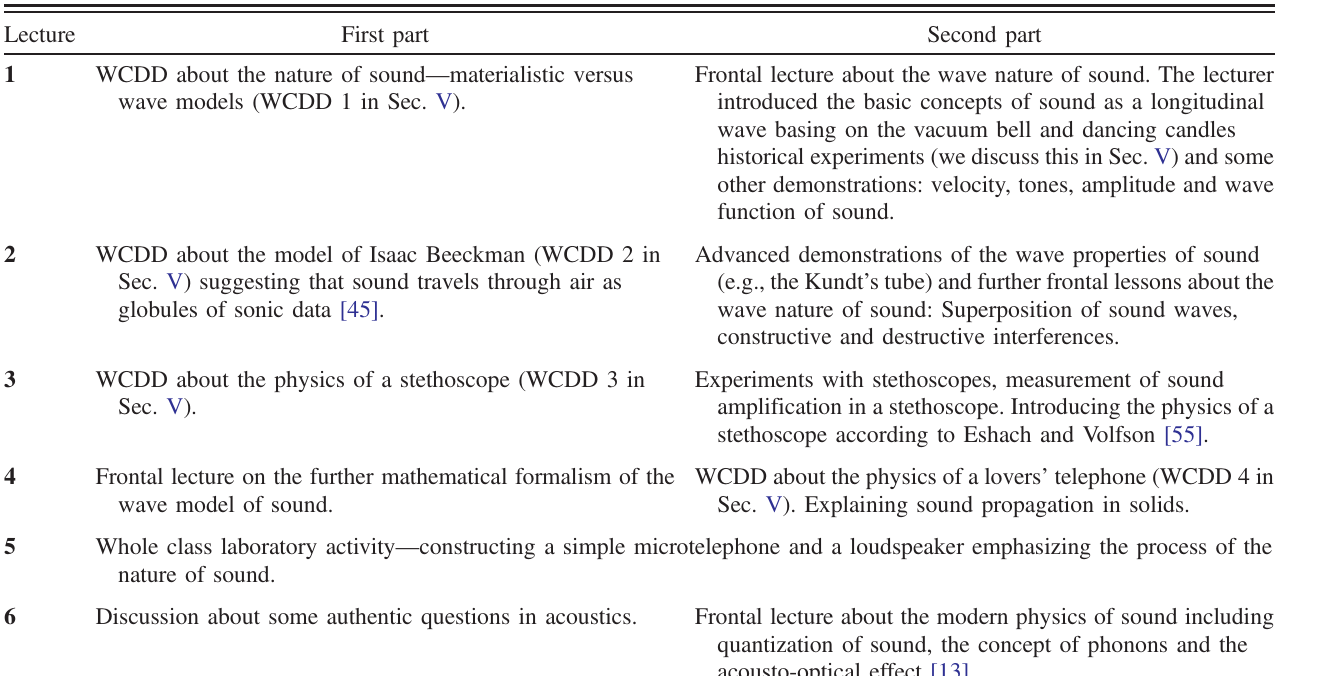
TABLE I. Brief summary of the course